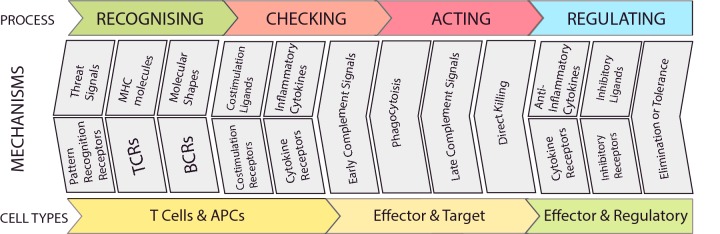
Overview of the Immune ProcessAn immune response goes through a number of stages. It begins by recognising that there is a threat from an infection. The response is controlled and directed by a number of checking mechanisms that optimise the system in parallel with effector mechanisms that target, limit, damage or destroy the threat. To contain ongoing damage, regulatory mechanism can dampen responses, promote memory and establish a state of tolerance.